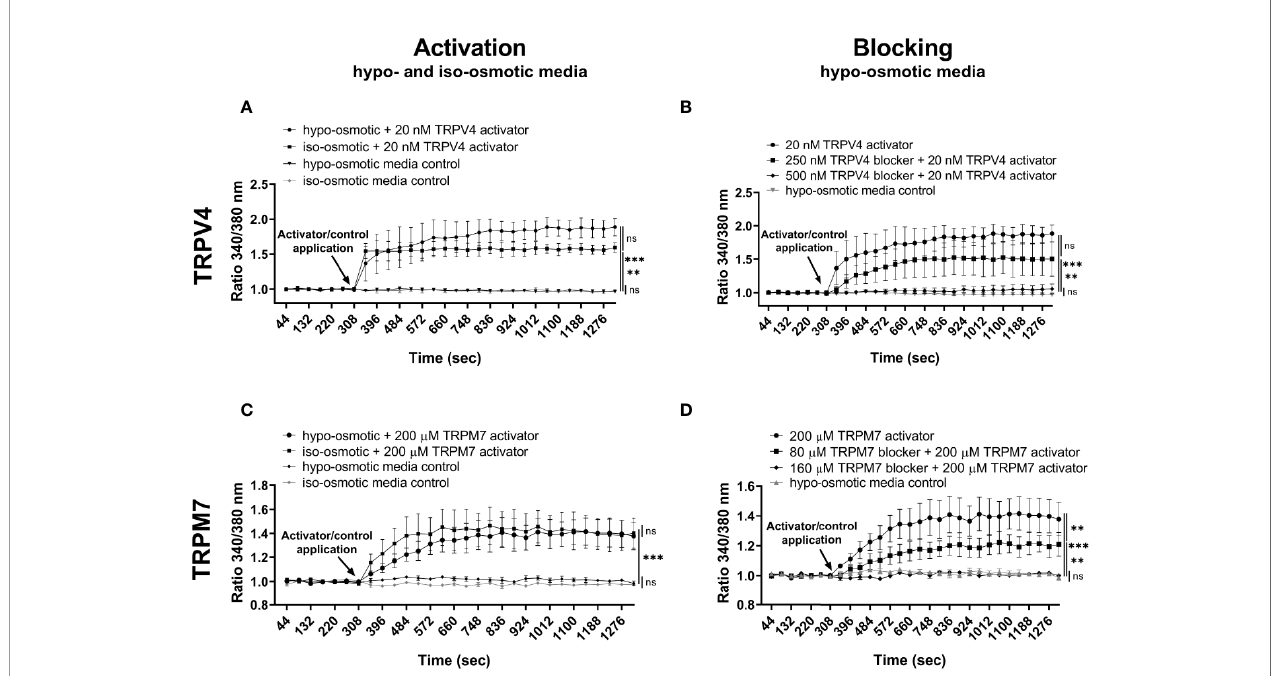
FIGURE 4 | Ca 2+ fl ux in NP cells following the application of (A) 20 nM GSK1016790A (TRPV4 activator) alone, (B) 250 or 500 nM GSK2193874 (TRPV4 blocker) and/or 20 nM GSK1016790A (TRPV4 activator), (C) 200 µM Naltriben (TRPM7 activator), and (D) 80 or 160 µM NS8593 hydrochloride (TRPM7 blocker) and/or 200 µM Naltriben (TRPM7 activator). Graphs present the ratio of the bound calcium to the unbound calcium (340 nm/380 nm) normalized to the baseline over the measurement time (mean ± SEM, bNP P2, n = 3). After the baseline measurement, empty (control) or compound-supplemented (treatment) media was added (indicated by an arrow on a graph) and the measurement was continued for up to around 15 min more. Asterisks indicate statistical signi fi cance (**p < 0.01, ***p < 0.001, ns , no statistical difference de fi ned as p > 0.05) as measured on the last measurement cycle.